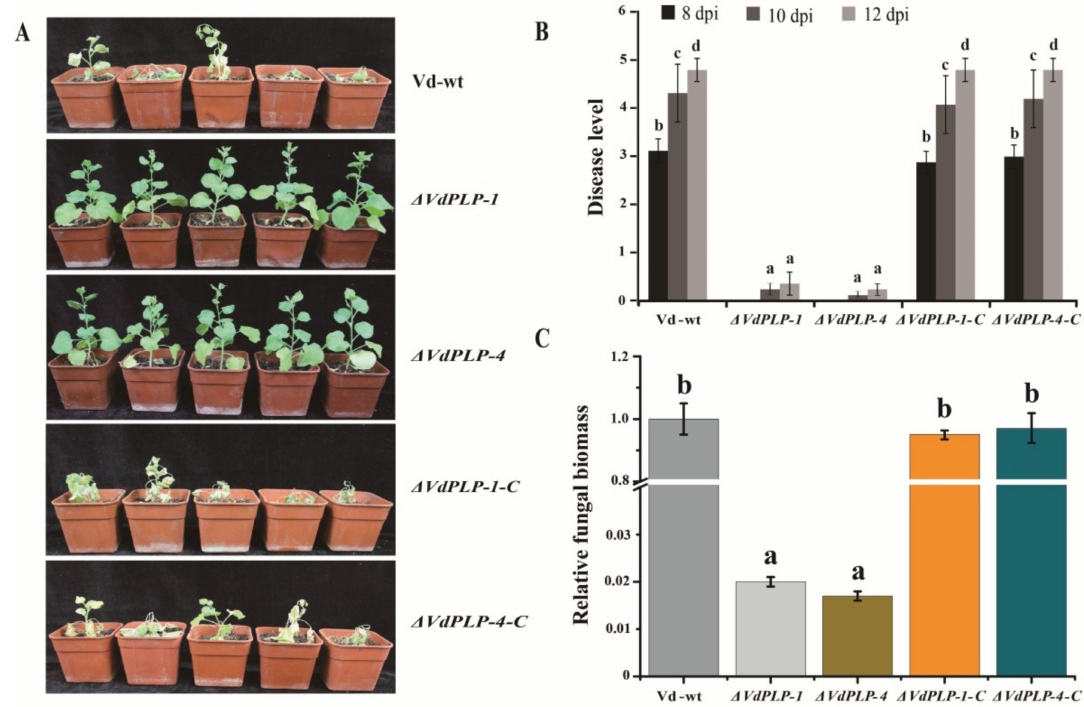
Figure 7. ∆ VdPLP mutant strains were not virulent on Nicotiana benthamiana in pathogenicity assays. ( A ) Representative plants 12 days post inoculation (dpi) with Vd-wt, ∆ VdPLP strains ( ∆ VdPLP-1 and ∆ VdPLP-4 ), or complementary ∆ VdPLP strains ( ∆ VdPLP-1-C and ∆ VdPLP-4-C ); ( B ) Disease level on N. benthamiana after a 2-min root-dip in conidia of the Vd-wt, ∆ VdPLP strains ( ∆ VdPLP-2 and ∆ VdPLP-4 ), and complementary ∆ VdPLP mutant ( ∆ VdPLP-1-C and ∆ VdPLP-4-C ) strains at 8, 10, and 12 dpi. See methods for severity scale; ( C ) Relative quantification of fungal biomass in N. benthamiana stems inoculated with conidial suspension of Vd-wt, ∆ VdPLP strains ( ∆ VdPLP-1 and ∆ VdPLP-4 ), and complementation ∆ VdPLP strains ( ∆ VdPLP-1-C and ∆ VdPLP-4-C ) at 12 dpi. Values are means ± SD from three independent replicates. Significant differences are indicated by letters (a–d), Duncan’s multiple range test ( p -value < 0.05) was used to analyze significant difference between each